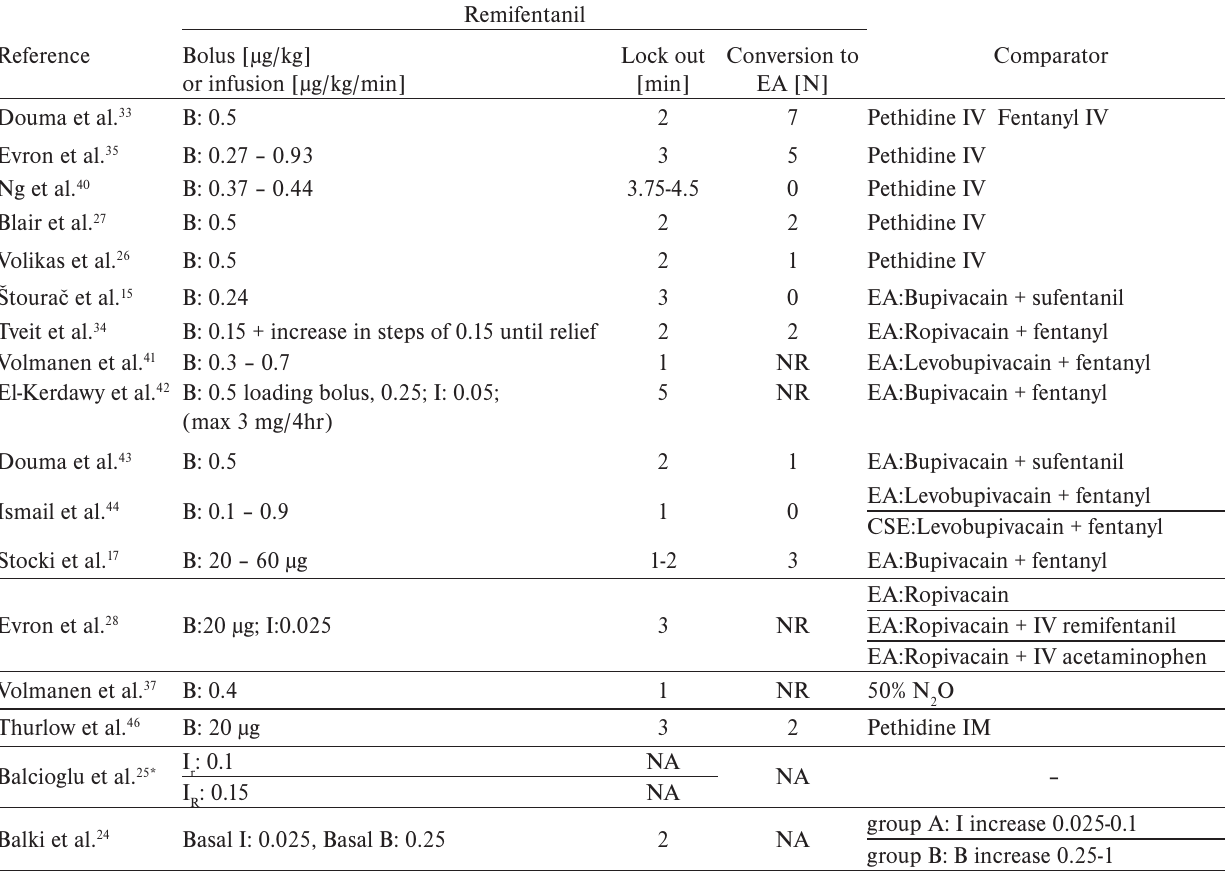
Table 3. Remifentanil RCTs that evaluated the efficacy for labour